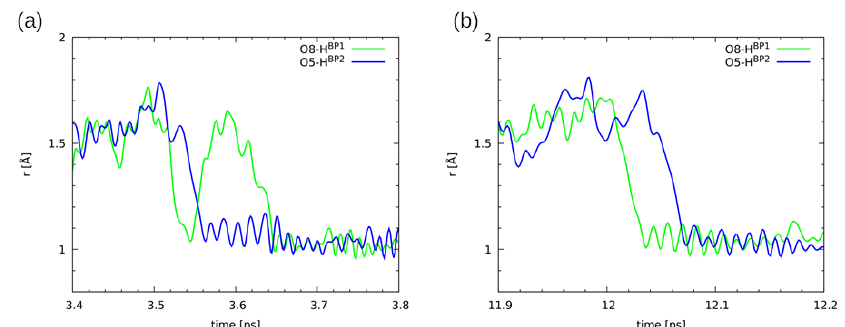
Figure 9. Details of two events of double proton transfer from the donor to the acceptor side—close- ups of the gas-phase CPMD trajectory at the room temperature at ( a ) 3.5 ps and ( b ) 12 ps of the simulation time. Both bridge protons are monitored so that the degree of correlation between their motions can be